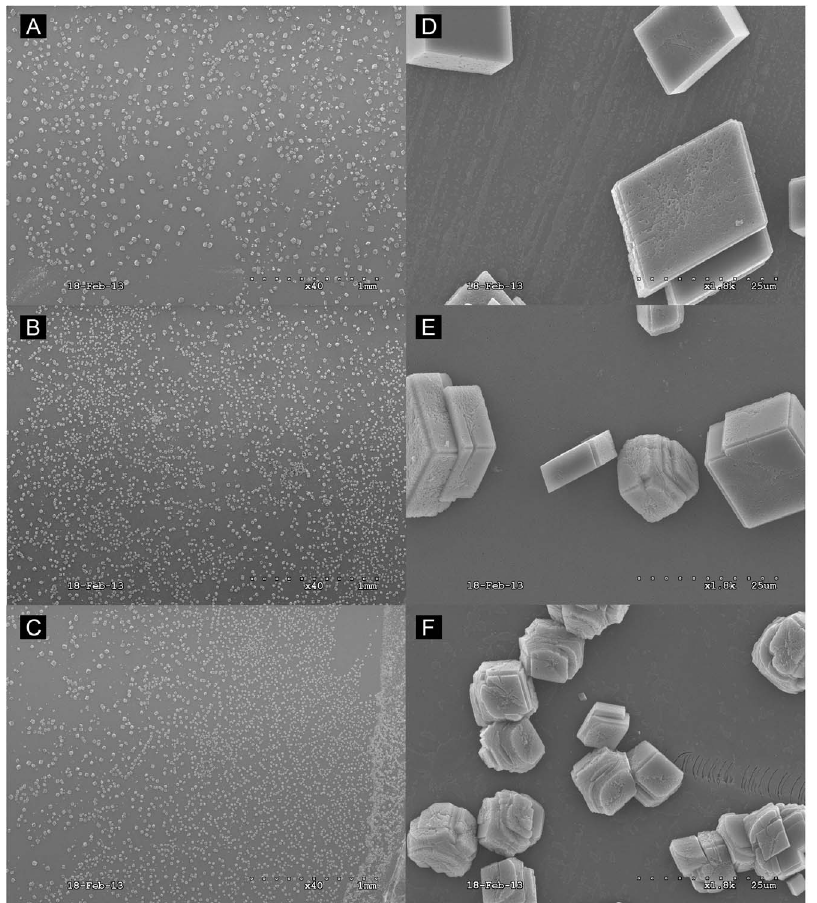
Figure 4. Scanning Electron Microscope Images of protein concentration dependent calcite modification by rmOC90. Varying concentrations of rmOC90 protein, (A and D) 100 nM rmOC90; (B and E) 500 nM rmOC90; (C and F) 1000 nM rmOC90 were dissolved in 7.5 mM CaCl 2 growth solution. Crystals were grown for 48 hours by slow evaporation of NH 4 HCO 3 into growth solution. Examination of the crystals was performed with JEOL JSM 6320F Field Emission scanning electron microscopy. Scale Bar, A–C: 1 mm; D–F: 25 m m.